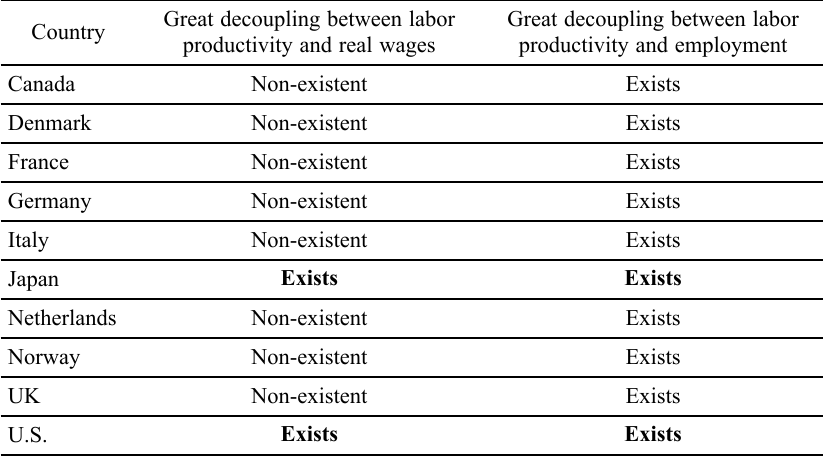
Source: authors’ calculation using data from The Conference Board Databases – Total Economy Database and International Labor Comparison program 2016, U.S. Bureau of Labor Statistics, Penn World Table